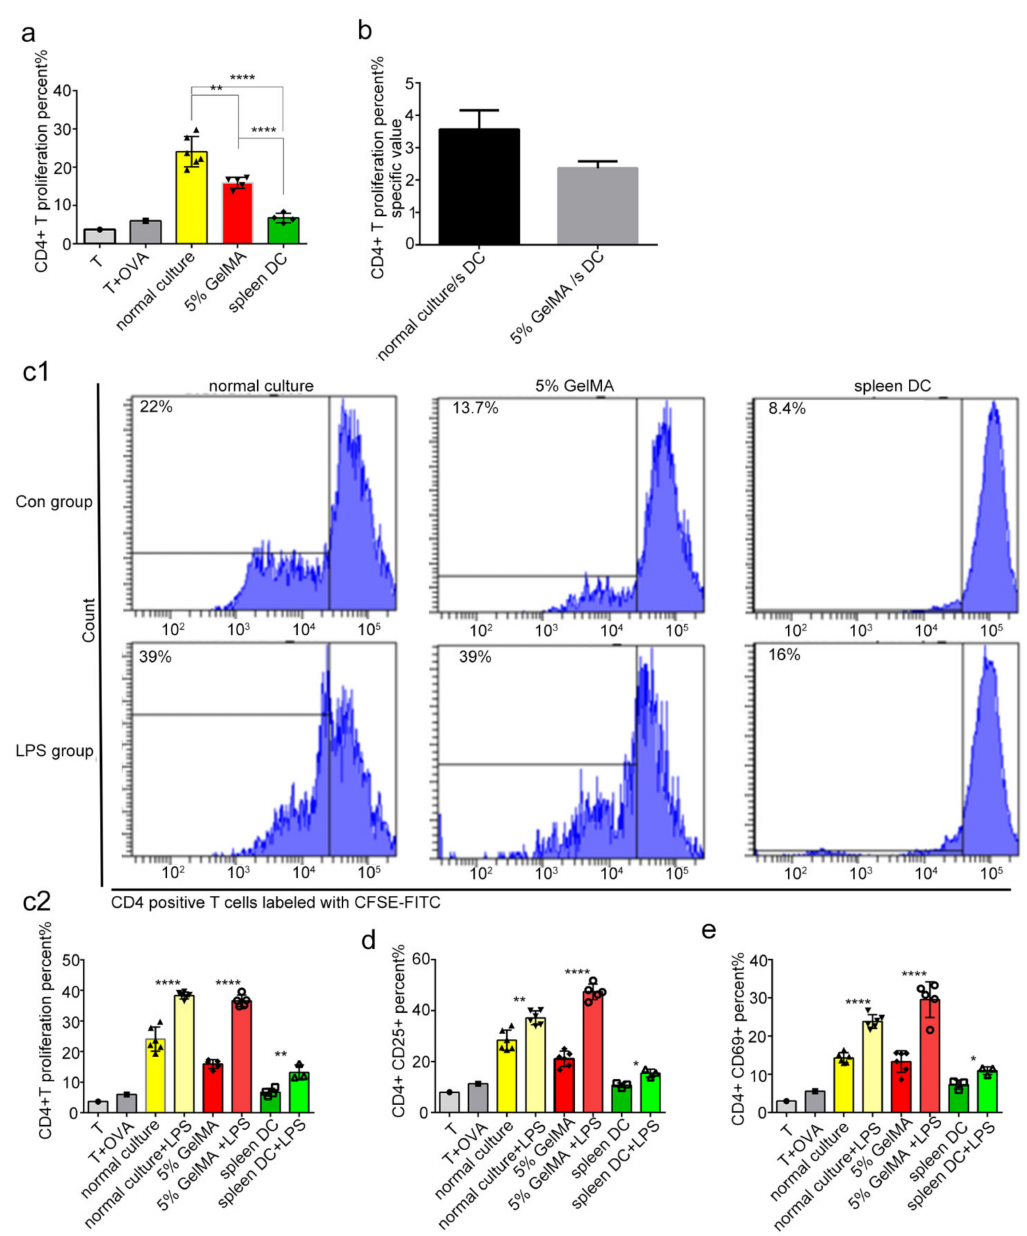
Figure 7. BMDCs cultured on 5% GelMA-30 were closer to the spleen DCs with more potential to activate T cells. ( a , c – e ) BMDCs from different culture systems and spleen DCs were stimulated with 100 ng/mL LPS, respectively, for 24 h. After 24 h, the collected DCs (10 4 cells) were co-cultured with CD4 + T cells (10 5 cells bound with CFSE-FITC) extracted from OT2 mice’s spleen with the existence of OVA-17 peptides for 64 h. After 64 h, the proliferation peak of CD4 + T cells and CD25 + or CD69 + cells were observed and measured using flow cytometry. Numbers above bracketed lines indicate percent CFSE low (proliferated) cells. Right, frequency of rapidly dividing cells among those at left. ( b ) The CD4 + T proliferation percent specific value was obtained from the ratio of the data of BMDCs from different culture systems, respectively, to the data of the spleen DC group. “s DC” represents the spleen DC. These experiments were repeated twice with essentially the same results. In all experiments, each picture was collected as means ± SEM, data were analyzed with unpaired student’s t test or analysis variance (ANOVA) and multiple comparison, and * p < 0.05, ** p < 0.01, **** p <